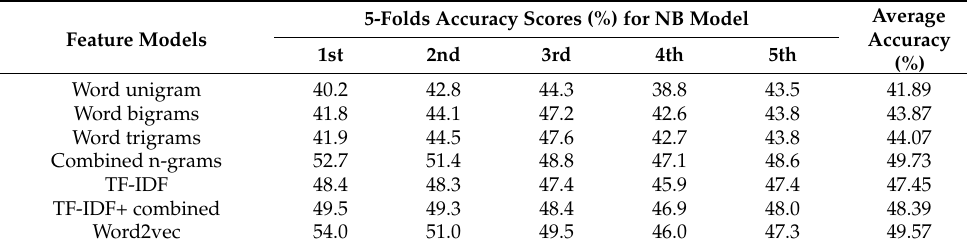
Table 12. NB models’ accuracy scores on each features using three class dataset.